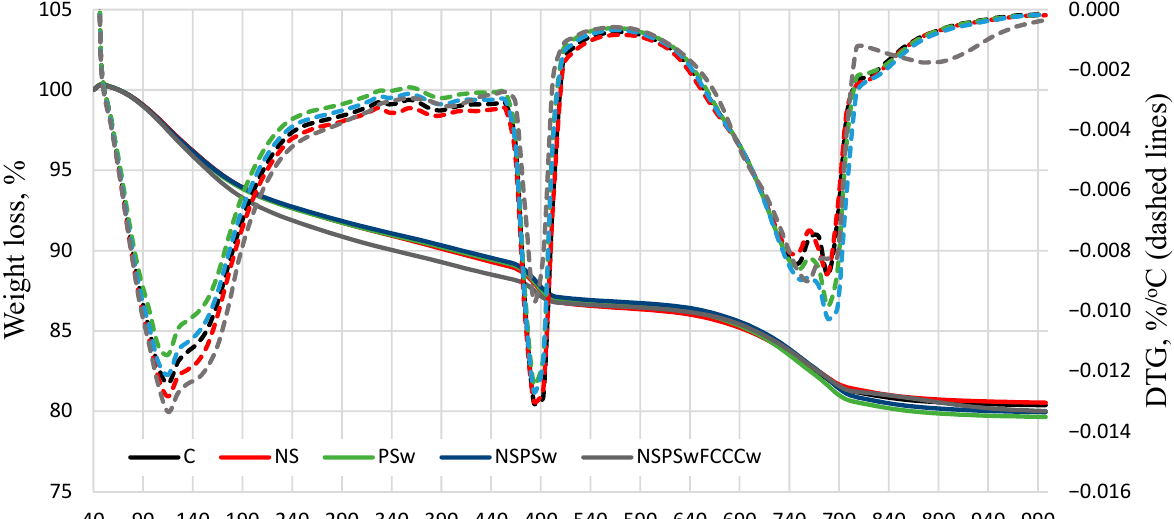
Figure 6. Results of derivative mass loss rate and cumulative mass loss at 28 days. Table 2. Mass loss in decomposition temperature ranges at 7 and 28 days.